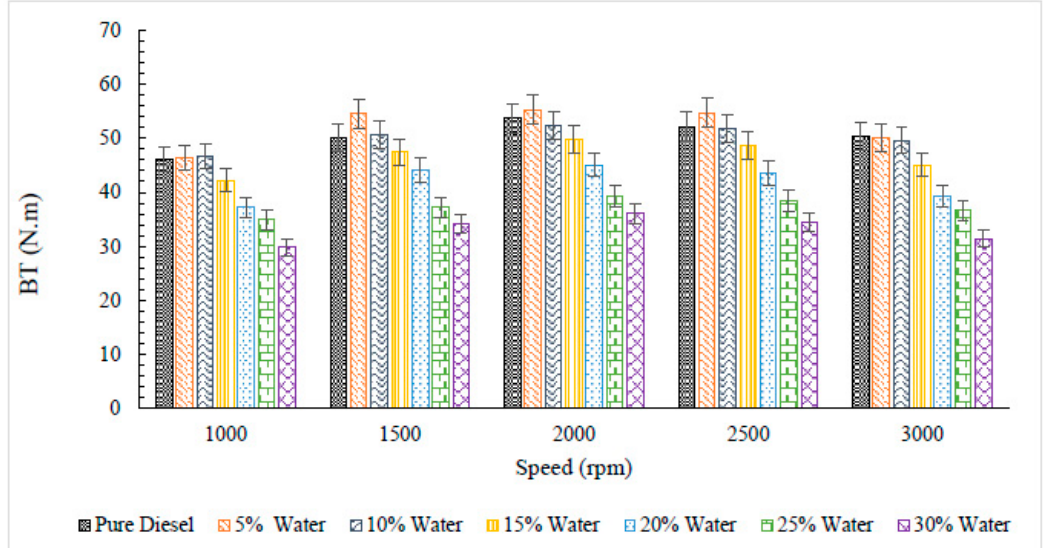
Figure 8. Effect of water-in-diesel emulsion fuel on brake torque of a diesel engine at different engine speed.